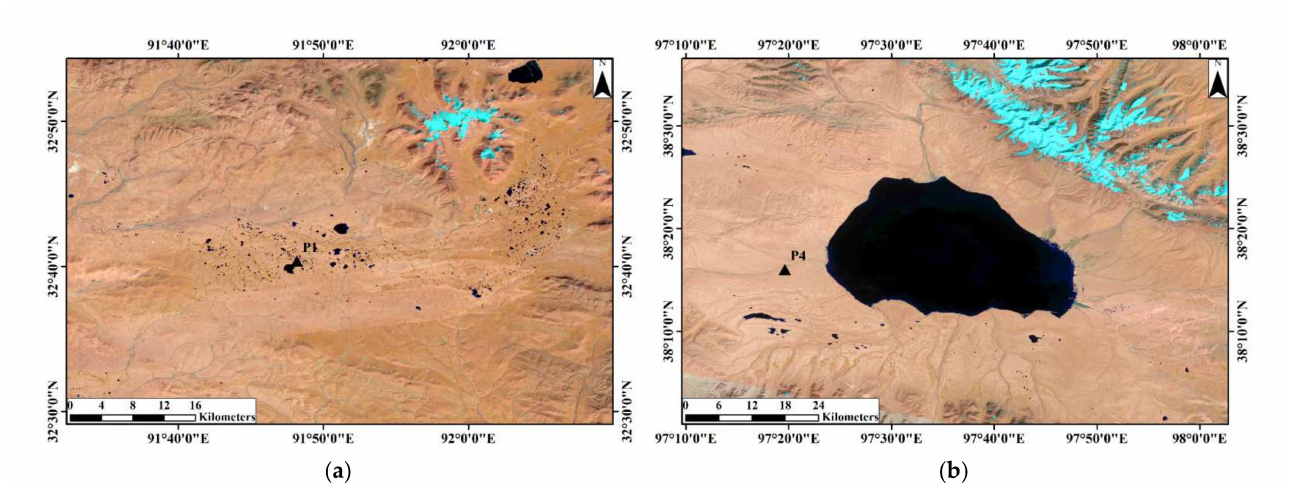
Figure 6. ( a , b ) show the optical images of P1 and P4 areas, respectively. There is a wide range of thermokarst lakes in P1 area; thermokarst lakes and polygonal cracks are distributed in P4